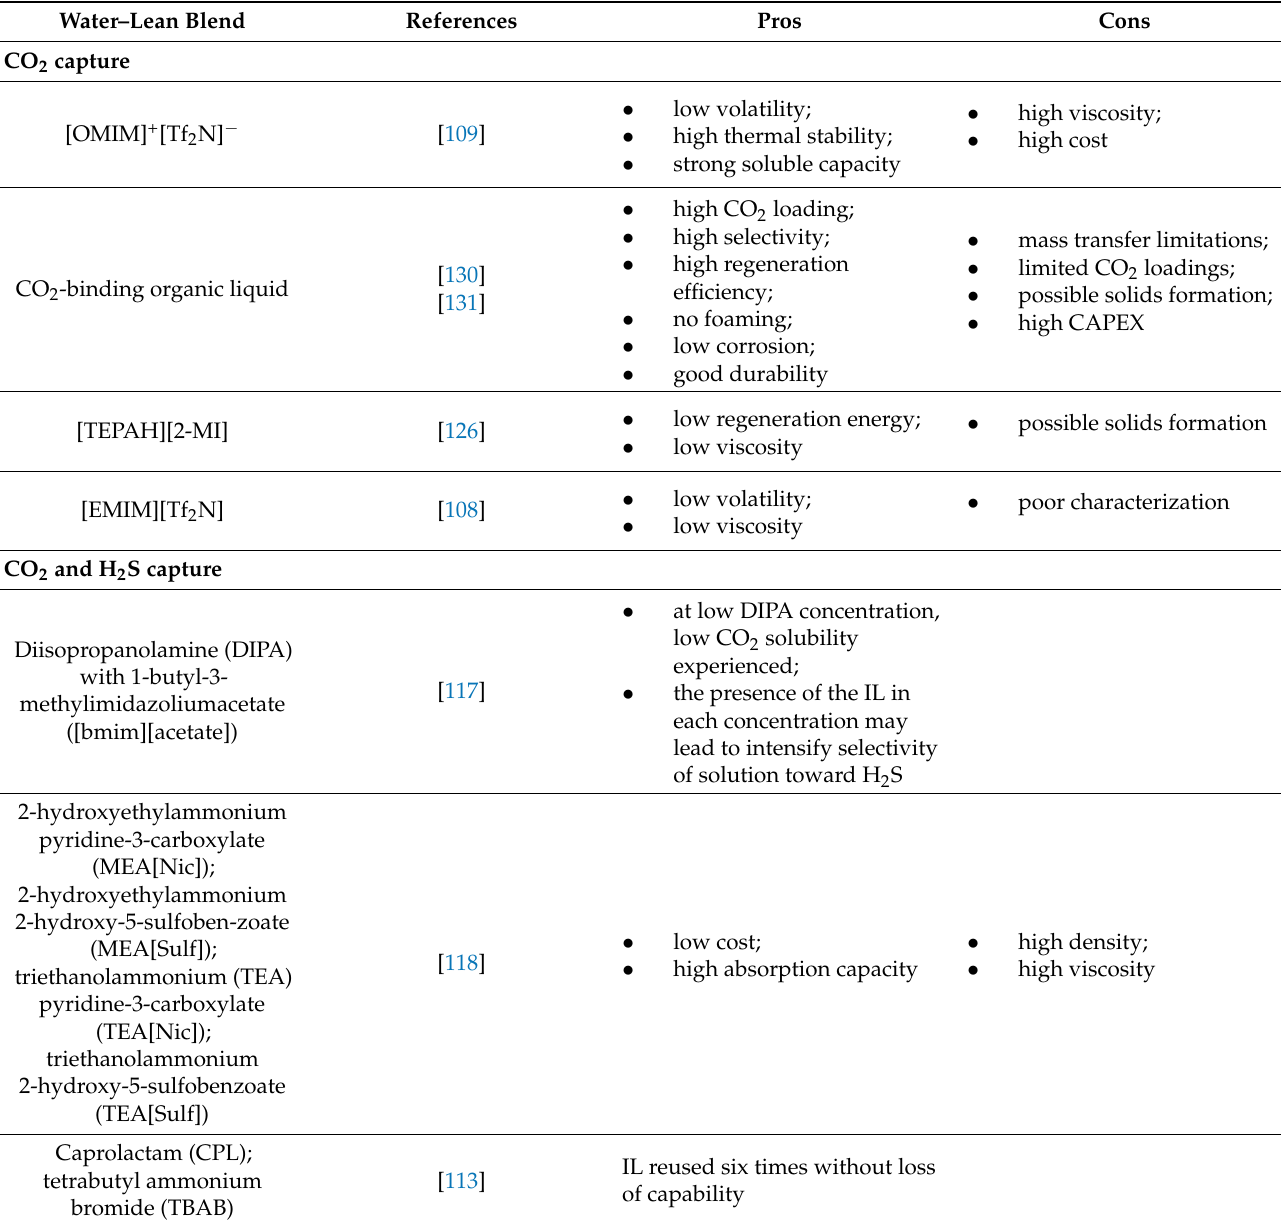
Table 4. Pros and cons of the water-lean solvents studied in the literature, considering both CO 2 capture and H 2 S and CO 2